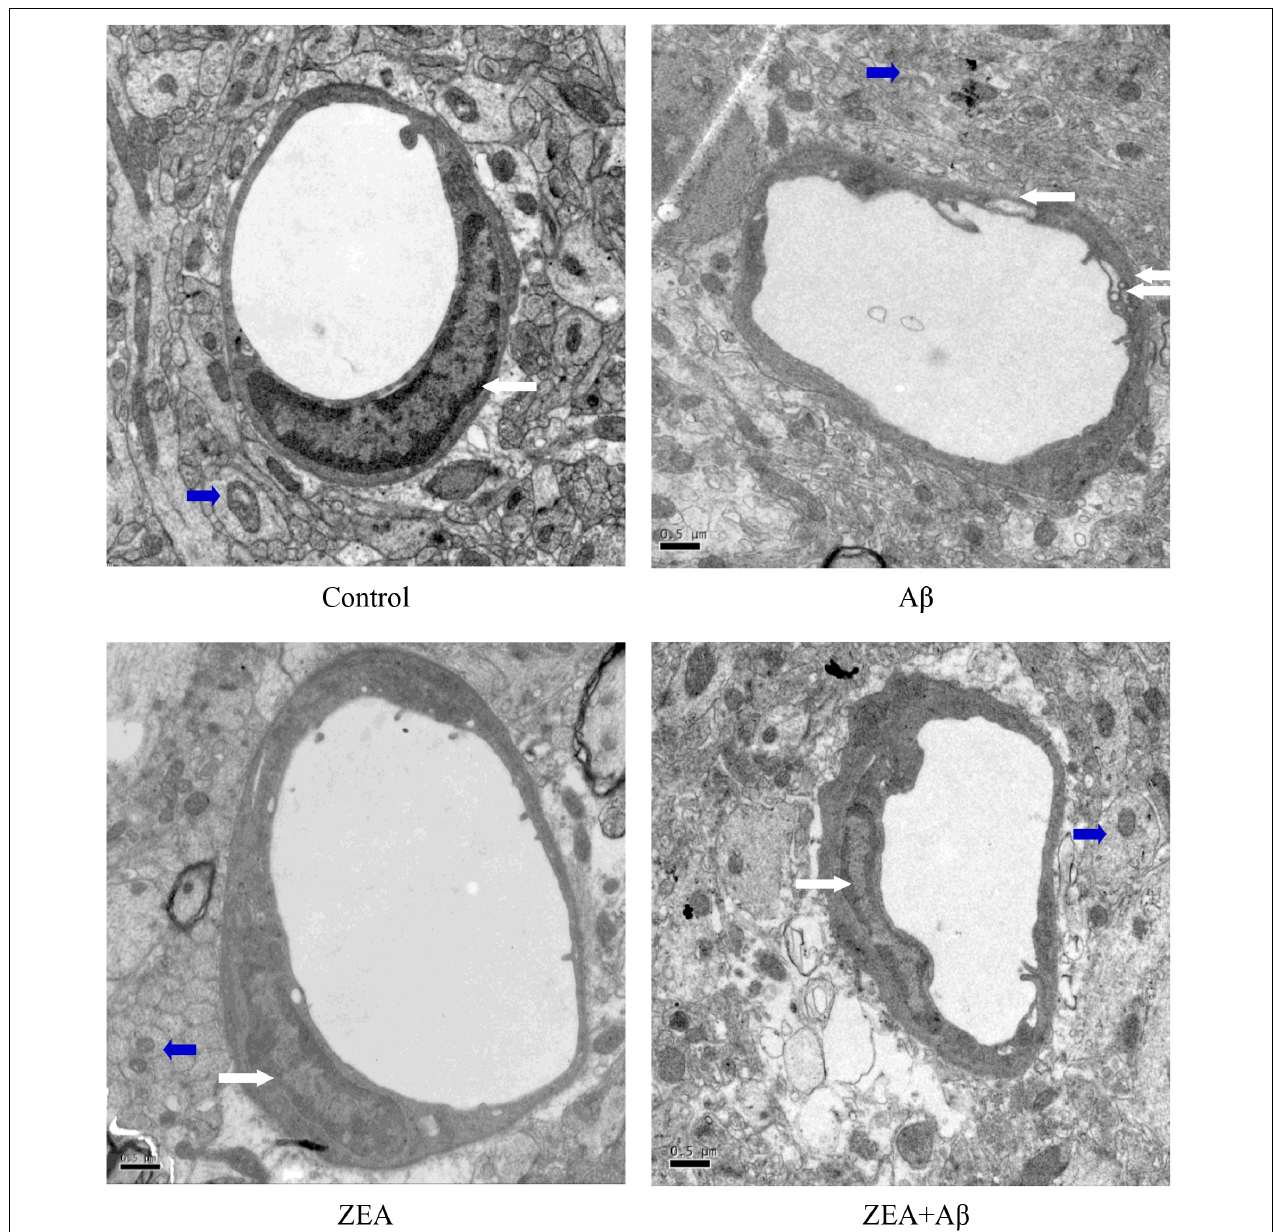
FIGURE 3 | The ultrastructure (10,000 × ) of cerebrovascular (White Arrows) and brain tissue (Blue Arrows) in different groups. A transmission electron microscope was used in the section of the whole rat brain from our four treatment groups mentioned before. Staff gauge showed 0.5 µ m at the left side of every picture’s